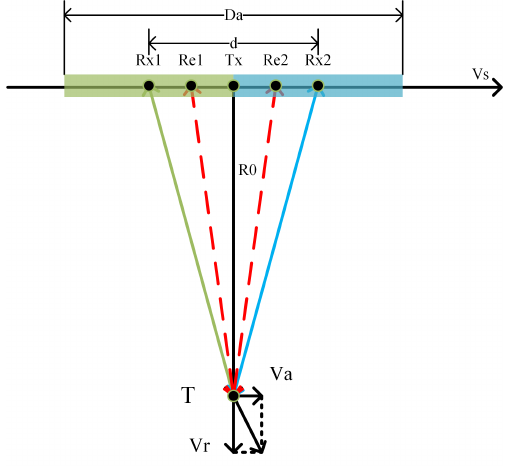
Figure 1. Geometric model in the azimuth-slant range